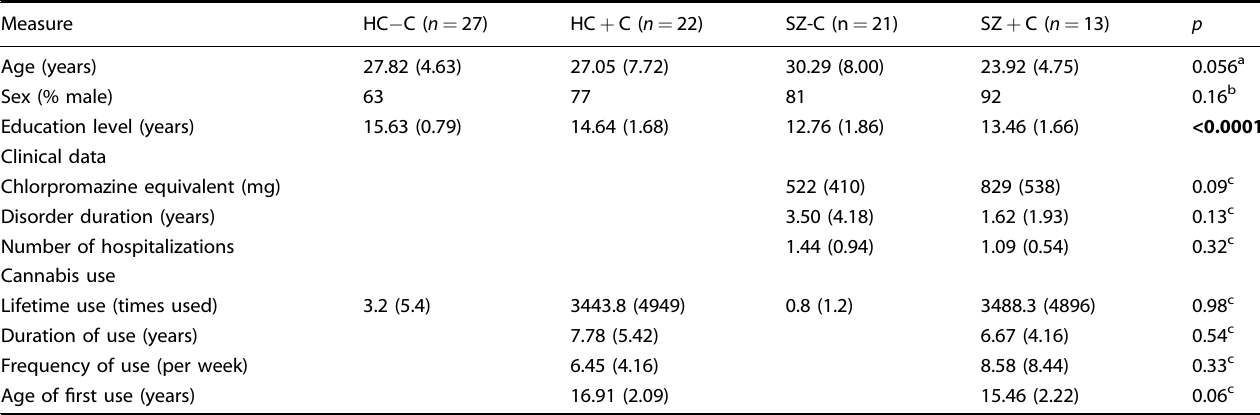
Table 1. Demographic data for the eighty-three participants that were included in the behavioural analysis.